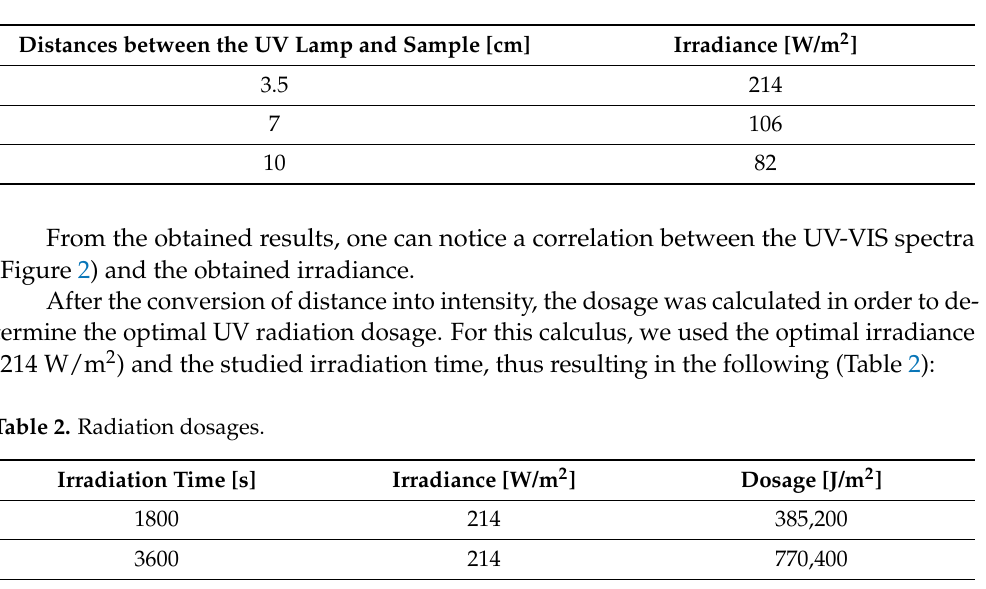
Table 1. Irradiance